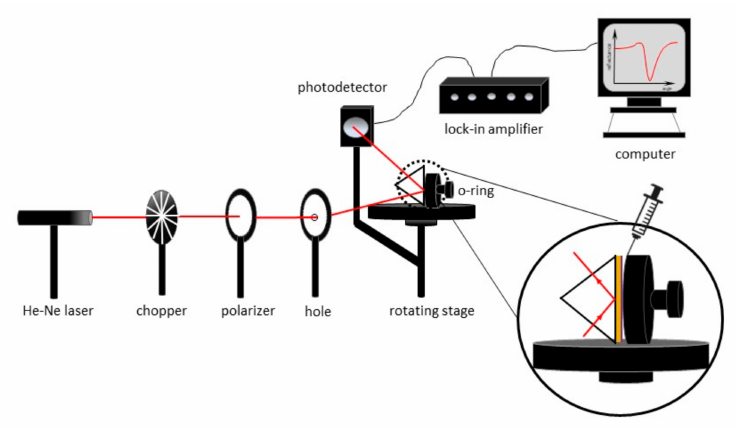
Figure 1. Schematic of the surface plasmon resonance